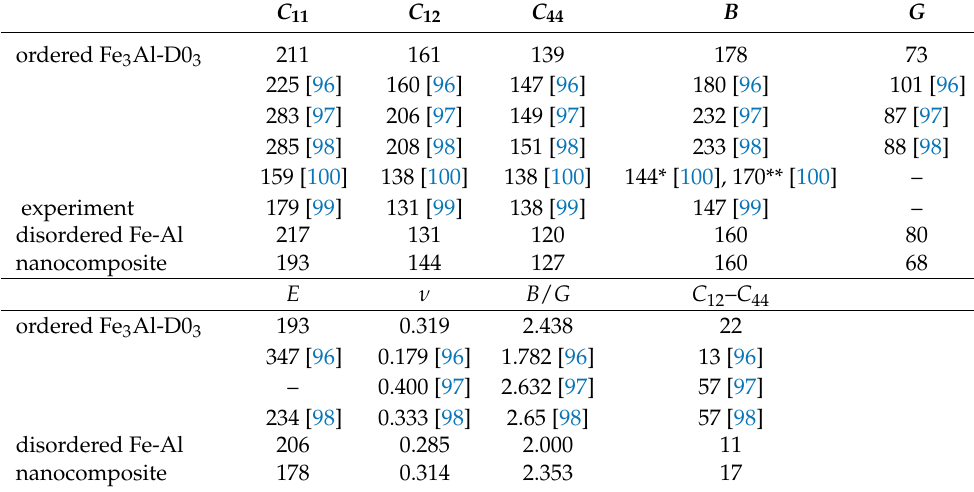
Table 3. The computed anisotropic elastic constants C 11 , C 12 and C 44 together with homogenized bulk modulus B , Young’s modulus E , shear modulus G , Poisson ratio ν and the Cauchy pressure C 12 – C 44 . The Table also contains previous theoretical results [96–98] as well as available experimental data [99]. All elastic constants (except for Poisson’s ratio) and moduli are given in